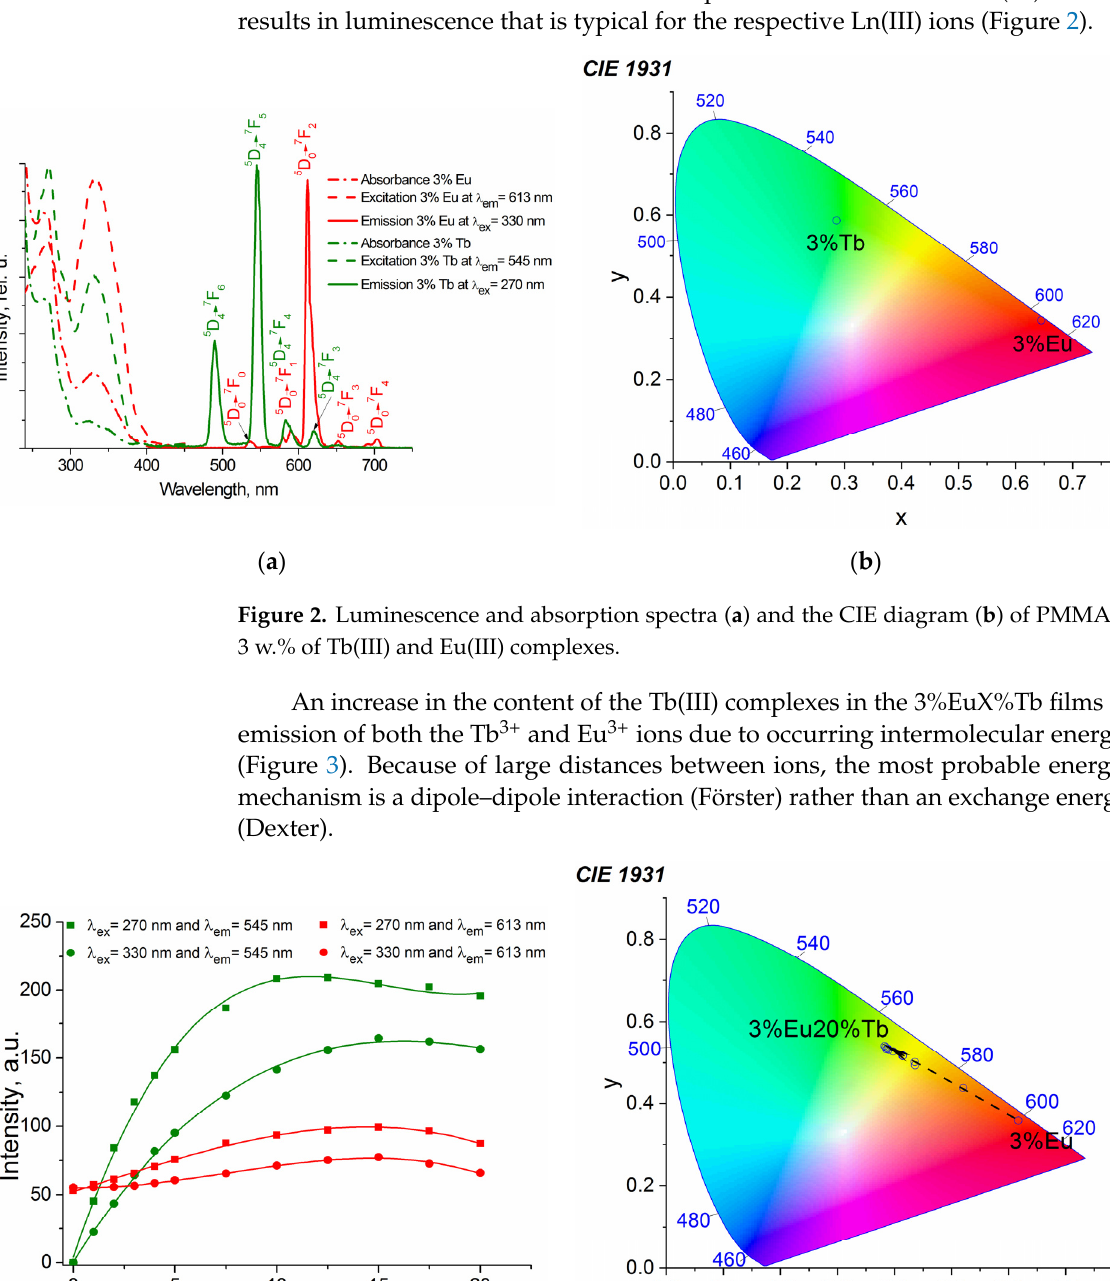
Figure 1. Synthesis of Ln(III) compounds.